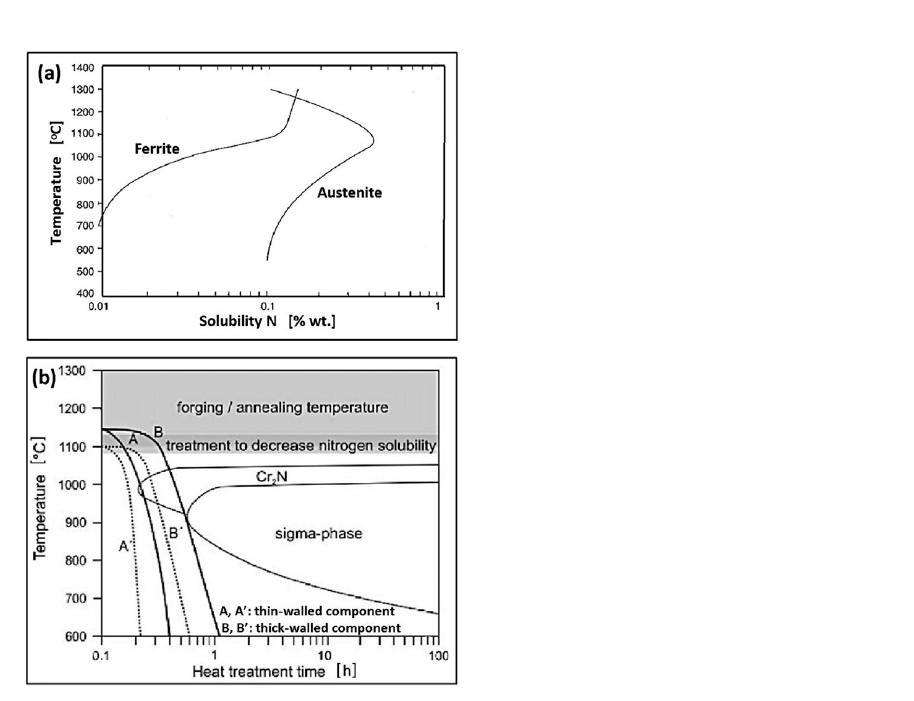
Figure 10. Heat treatment of duplex steel, including ( a ) solubility of Nitrogen in ferrite and austenite (according to [38]), ( b ) heat treatment of the thin-walled and thick-walled duplex steel elements (according to [23]).